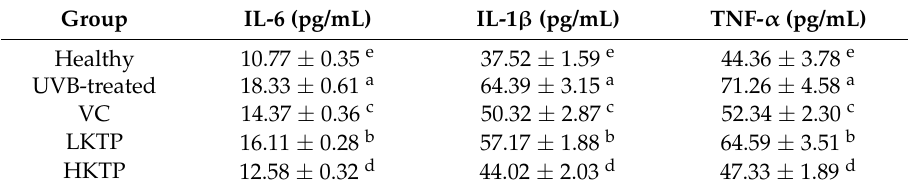
Table 3. Serum levels of cytokines IL-6, IL-1 β , and TNF- α in SKH1 hairless mice with UVB-induced skin aging.